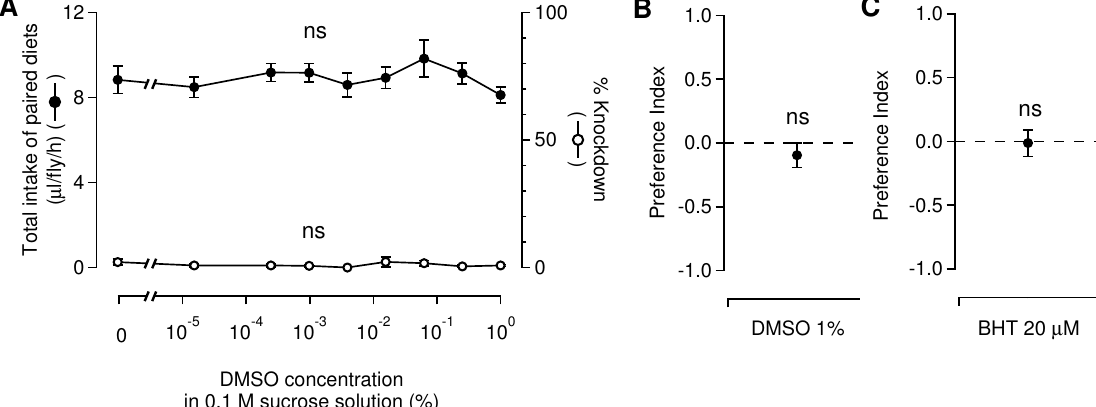
Figure 2. Baseline validation of a dual-choice feeding assay: impact of DMSO and BHT on the feeding preference of blowflies. ( A ) The mean values of individual food intake and knockdown (KD) rates are shown as a function of DMSO concentration. An increased concentration of DMSO did not change the average values of individual food intake (ANOVA, df = 8, F = 0.636, p = 0.742) and did not increase the KD rate (one sample t -test vs a KD rate of 0%, p > 0.563). ( B ) 1% DMSO in sucrose solution did not reduce the average of PIs from PI = 0 (one sample t -test, p = 0.424). ( C ) 20 µ M of BHT, the amount contained in the initial concentration (1 mM) of synthetic pyrethrins, did not change the average of PIs (one sample t -test, p = 0.918). Error bars indicate standard error of the mean ( n = 5 repetitions).